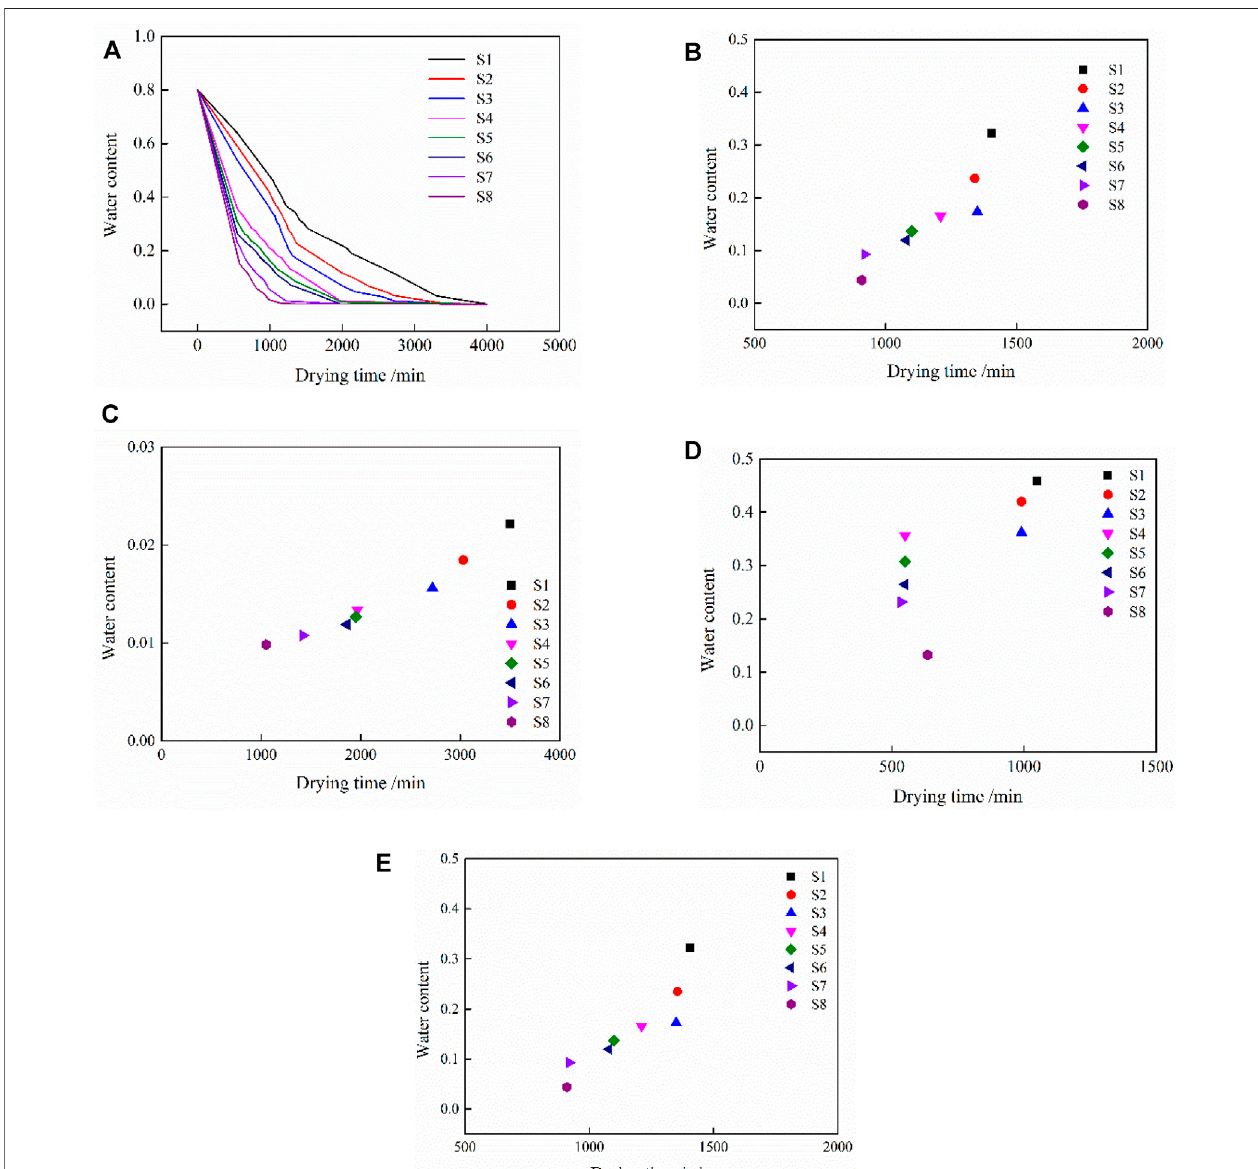
FIGURE 7 | Variation of the water content during the drying process: (A) Relationship between the water content and drying time for different materials. (B) Relationship between water content and time for different materials when the number of blocks was stable. (C) Relationship between the water content and time for different materials when the width of crack was stable. (D) Relationship between the water content and time for different materials when the fi rst crack occurred. (E) Relationship between water content and time for different materials when the length of crack was stable.